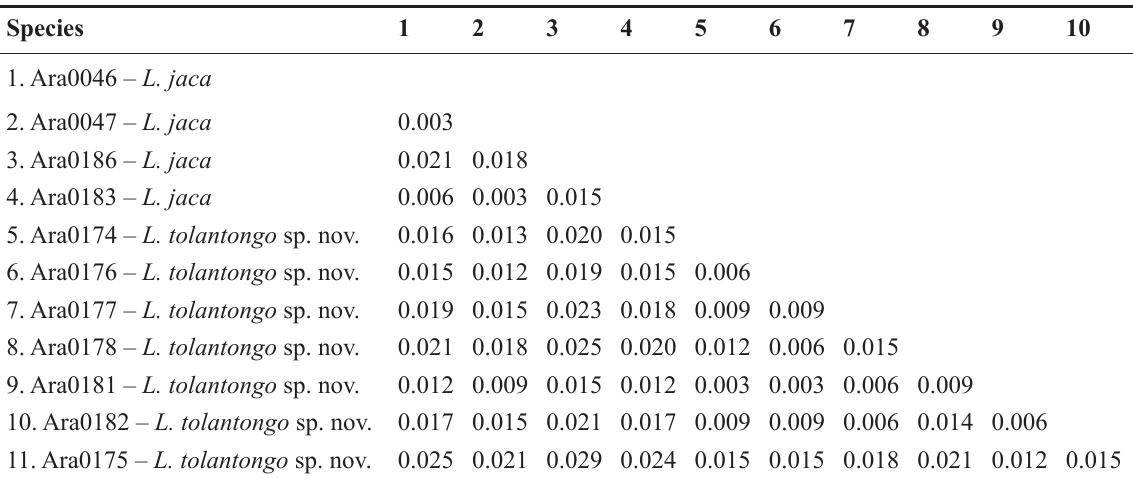
Table 4. Genetic p -distance matrix from the ITS2 data between Loxosceles tolantongo sp. nov. and L. jaca Gertsch & Ennik, 1983. Average p- distance = Species